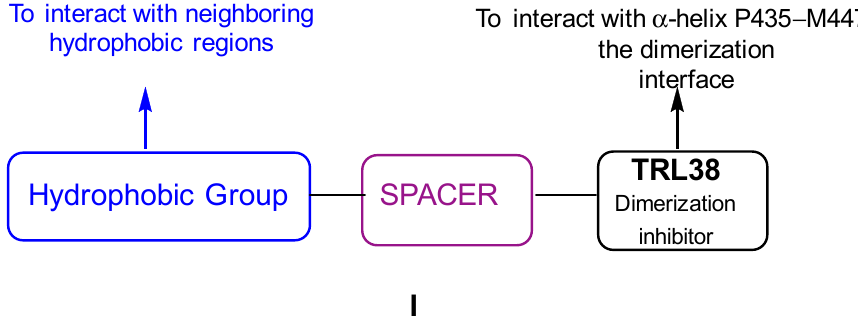
Figure 2. General structure of the novel small molecule TRL38 conjugate.